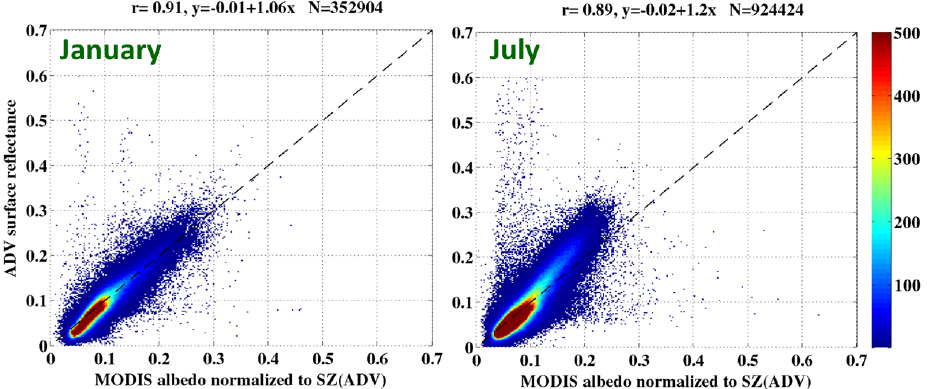
Figure 12. ADV vs MODIS point-to-point surface reflectance for 555nm for January (left) and July (right). Color (legend) represents the frequency of the observations.